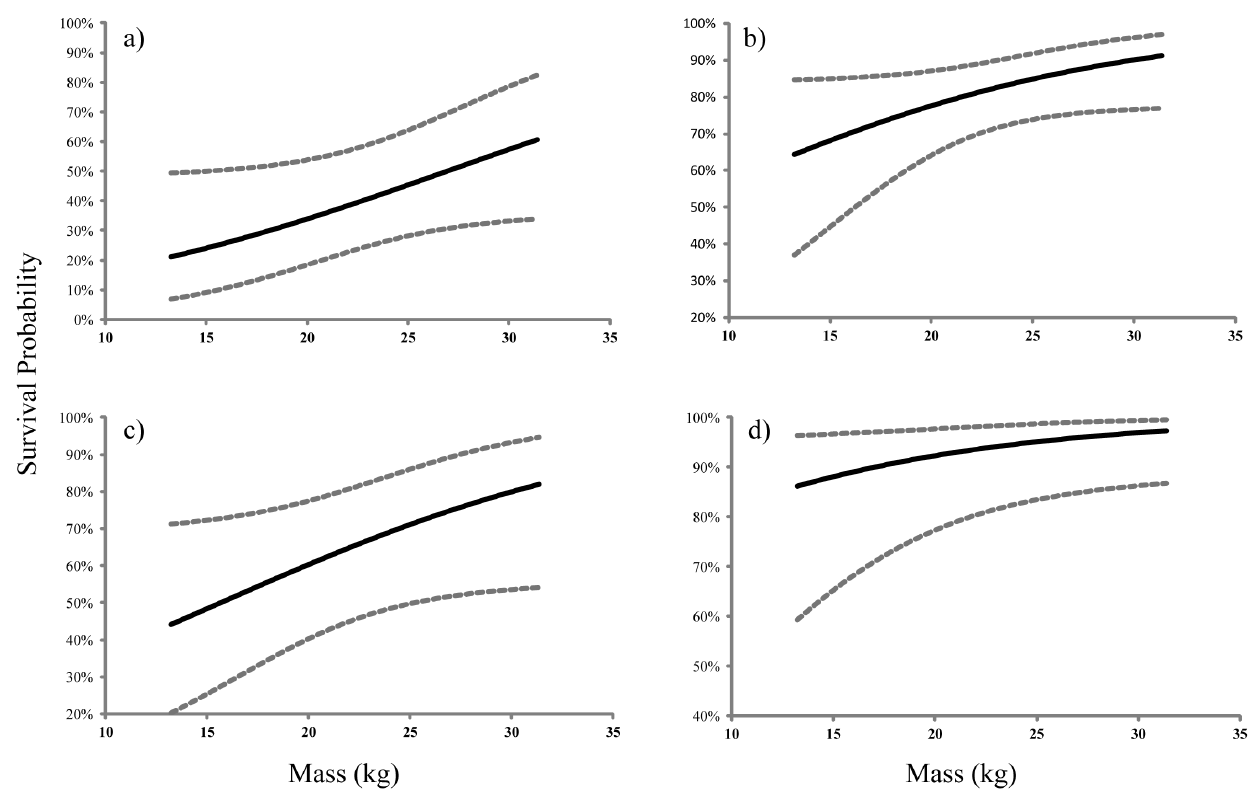
Figure 5. Survival probabilities for male and female juveniles at age during the period of the decline (open squares; Pendleton et al. 2006) and during the 2000s (closed diamonds; this study).